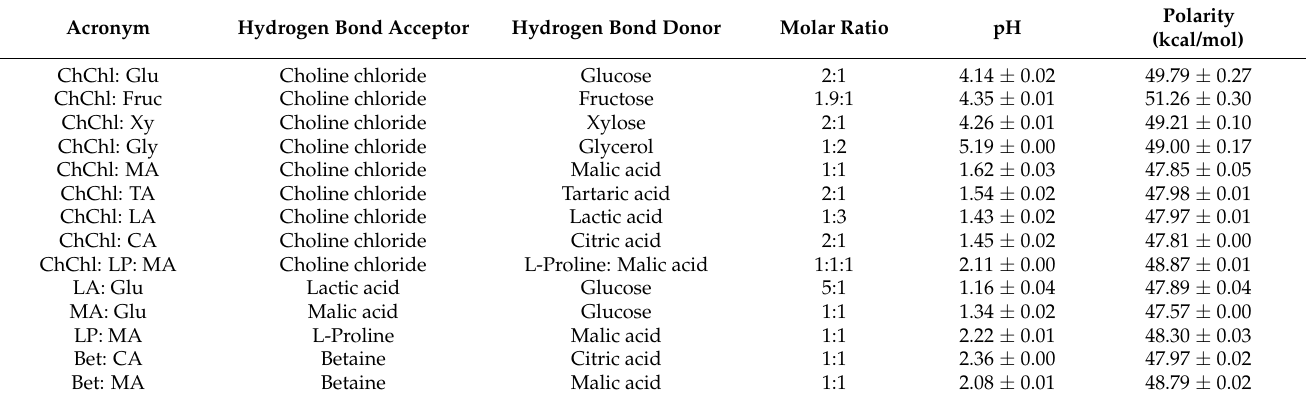
Table 1. Used NADES and their physicochemical